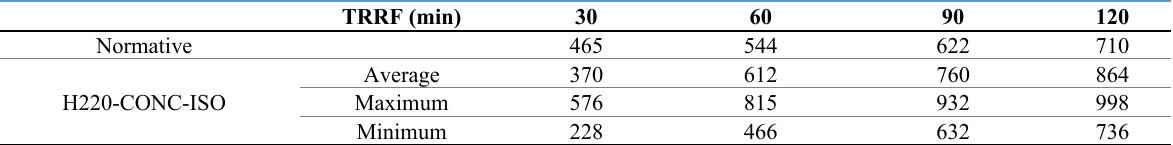
Table 5 - Comparison of the temperatures obtained in the numerical model with the normative values for the steel profile web for the isolated composite column.